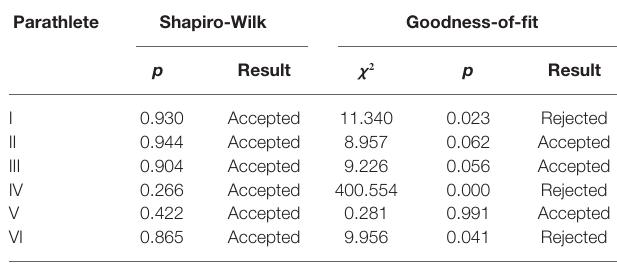
TABLE 3 | Normality tests and goodness-of-fit for the linear regression of the marker CK ( Y ) as a function ofwe ( X ). Parathlete Shapiro-Wilk